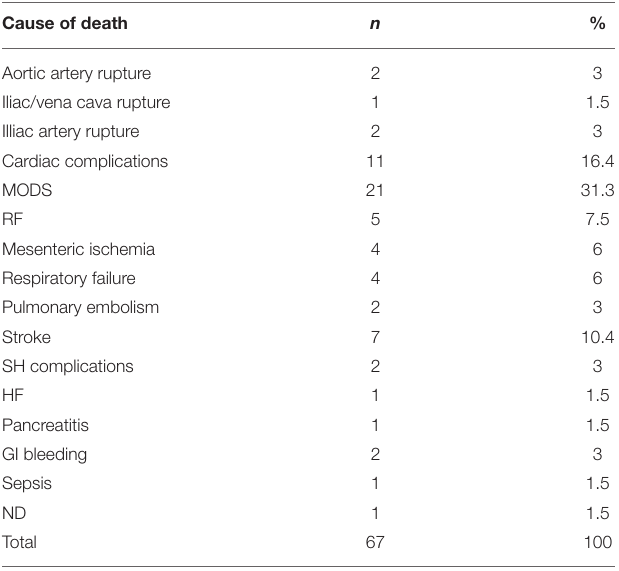
TABLE 4 | Causes of 30-day